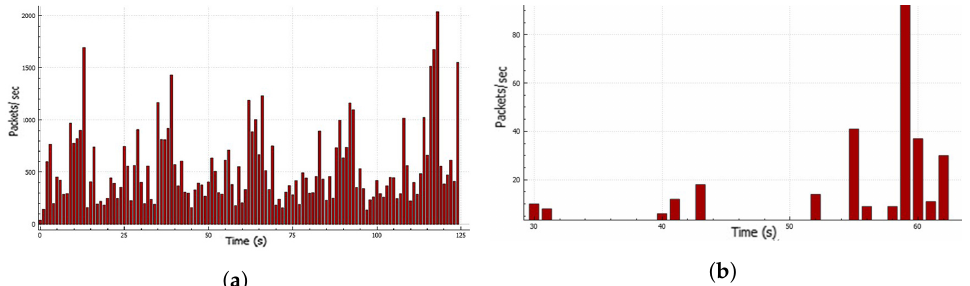
Figure 9. Rate representation during data preparation: ( a ) traffic rate from single LOIC instance and ( b ) rate during normal browsing of the